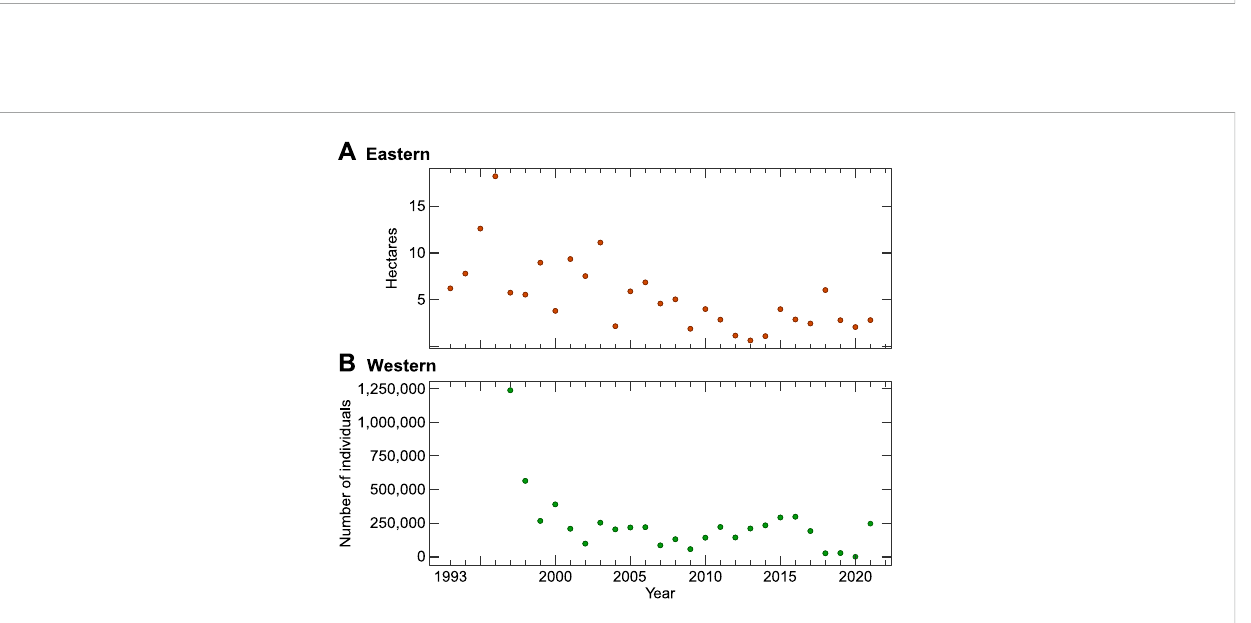
FIGURE 3 The number of hectares of overwintering habitat ( (A) , Eastern) and individuals ( (B) , Western) by year for the two monarch populations. Standardized monitoring of overwintering populations began in 1993 in Mexico (Rendón-Salinas et al., 2020) and 1997 in California (Xerces Society, 2022).